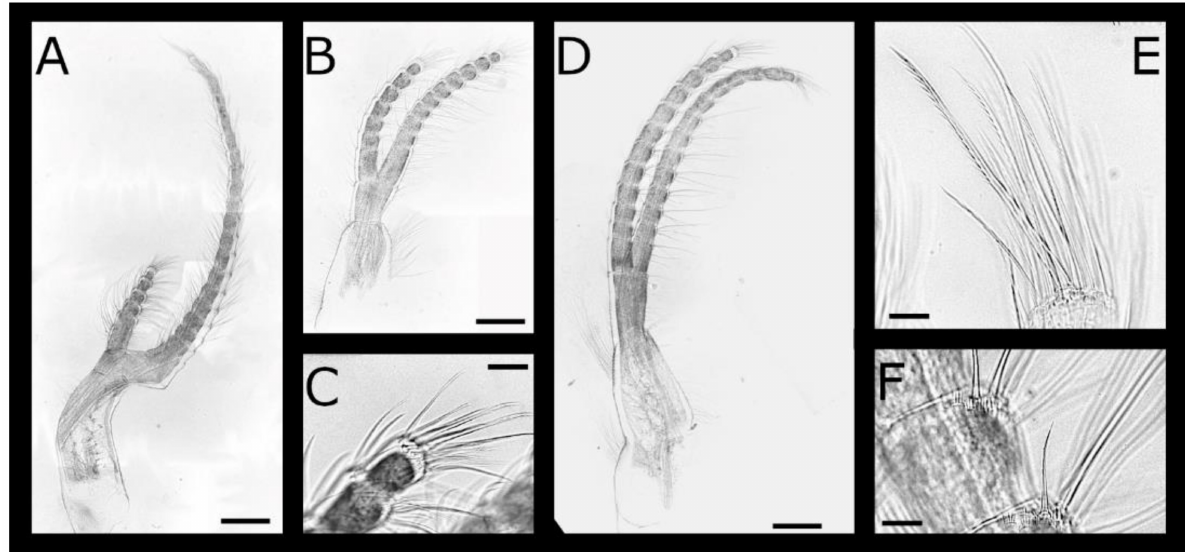
Figure 11. Euacasta acutaflava sp. nov. cirri I–III of holotype (WAM C58744) ( A ) left cirrus I; ( B ) left cirrus II; ( C ) terminal segment of left cirrus II posterior ramus; ( D ) left cirrus III; ( E ) serrulate setae on terminal segment of right cirrus III posterior ramus; ( F ) medial segments of left cirrus III anterior ramus, arrows indicate ctenoid scales. Scale bars: A–B, D = 200 µ m; C, E–F = 50 µ